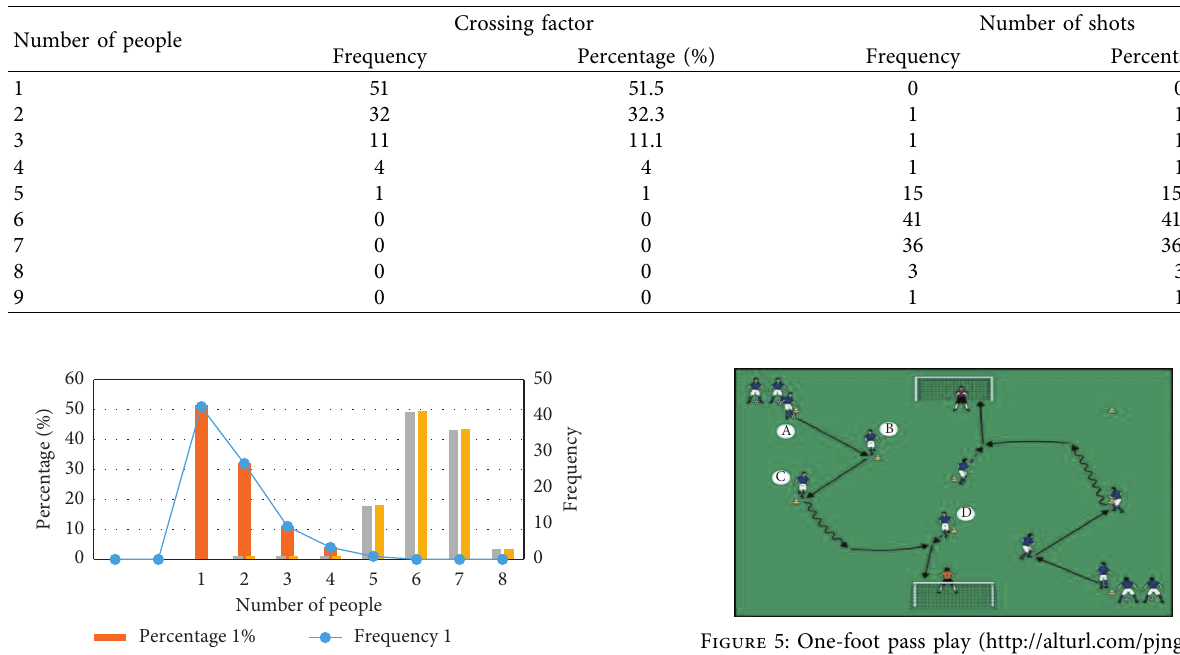
Figure 3: Fast layout during football drill (http://alturl.com/ymozb). Table 3: The relationship between the passing factors and their observed variables.